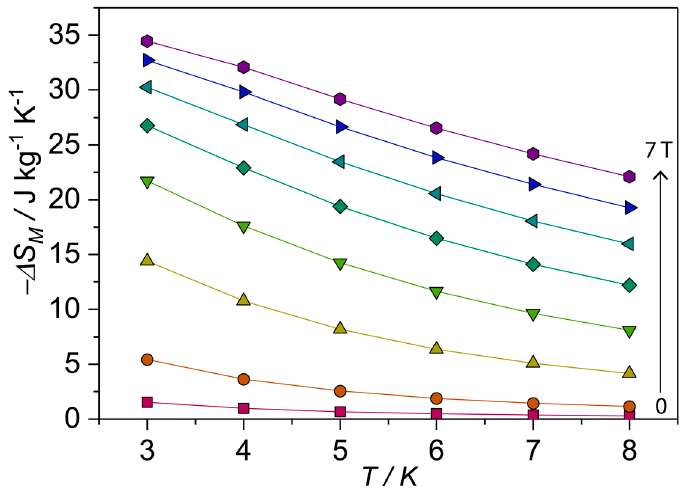
Figure 5. Magnetic entropy changes for compound 1 calculated from isothermal magnetization measurements.